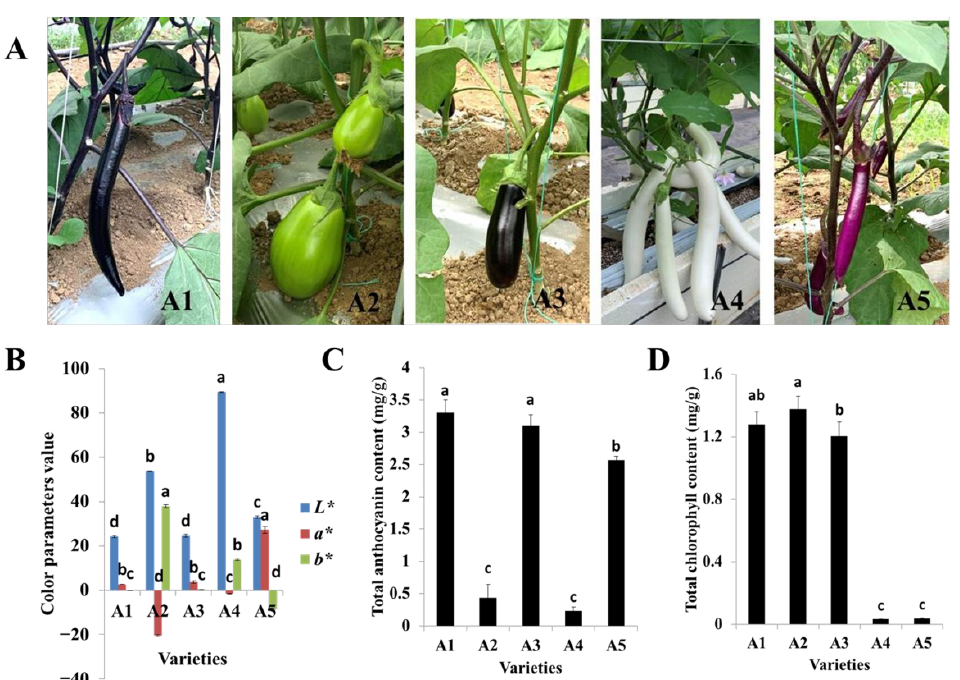
Figure 1. Phenotypes of the five eggplant varieties with different fruit colors. ( A ) Morphologies of the fruits of the five eggplant varieties; ( B ) Color parameters of fruit peels of the five eggplant varieties; ( C ) Total anthocyanin contents of the five eggplant varieties; ( D ) Total chlorophyll contents of the five eggplant varieties. The different letters on top of each bar indicate significant differences among the five eggplant varieties at p < 0.05.